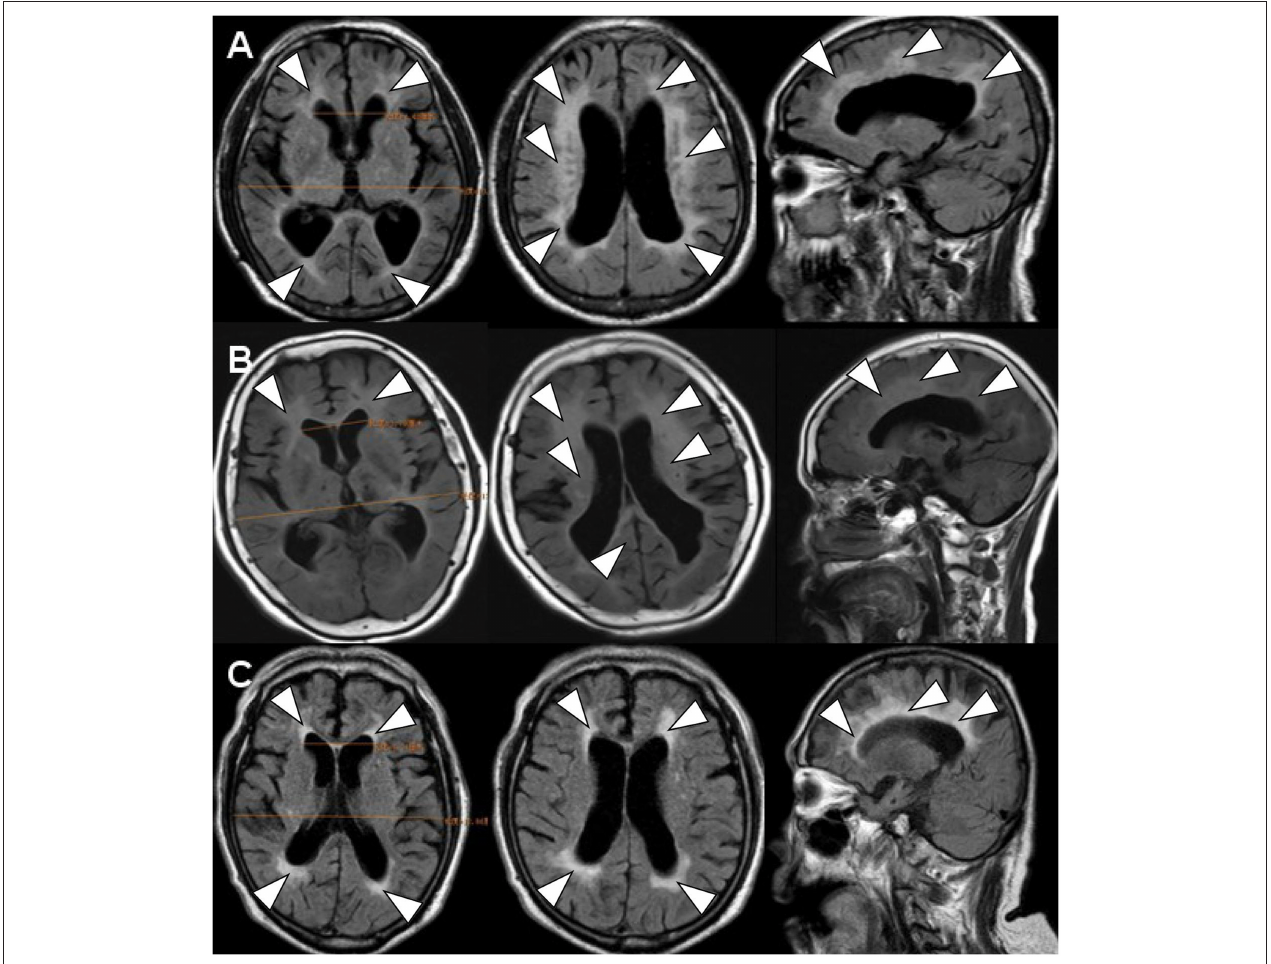
FIGURE 1 | The brain FLAIR-MR imaging. FLAIR-MRI demonstrated the similar image feature of ventricular dilation (Evan index > 0.3) (1) and periventricular (2) and deep white matter changes (3) in all of three cases. (A) denoted as INPH (case 1); (B) denoted as LA (case 2); (C) denoted as CAA (case